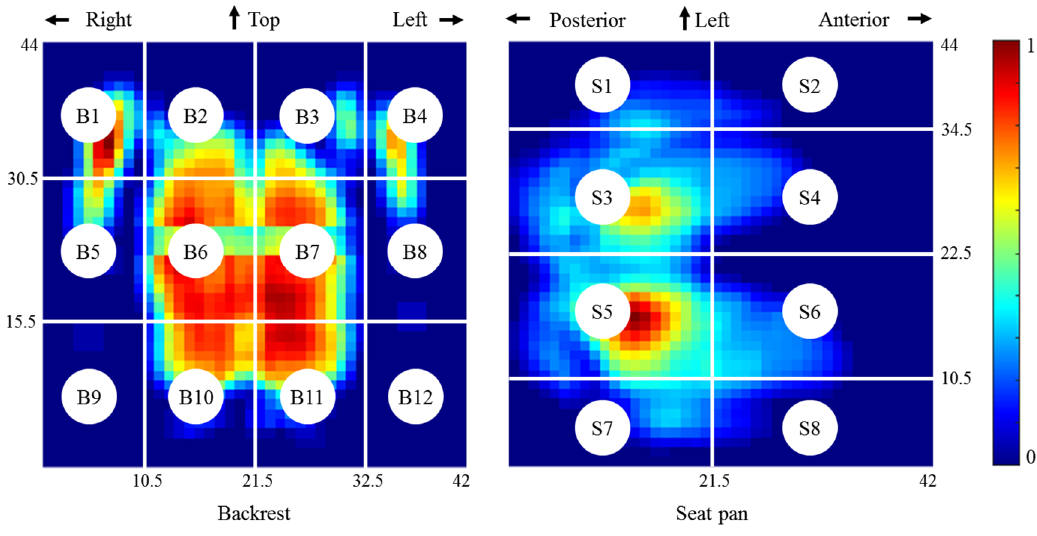
Figure 4. Pressure mat segmentation. The pressure distributions on the backrest (left) and seat pan (right) were normalized by the respective peak pressure.